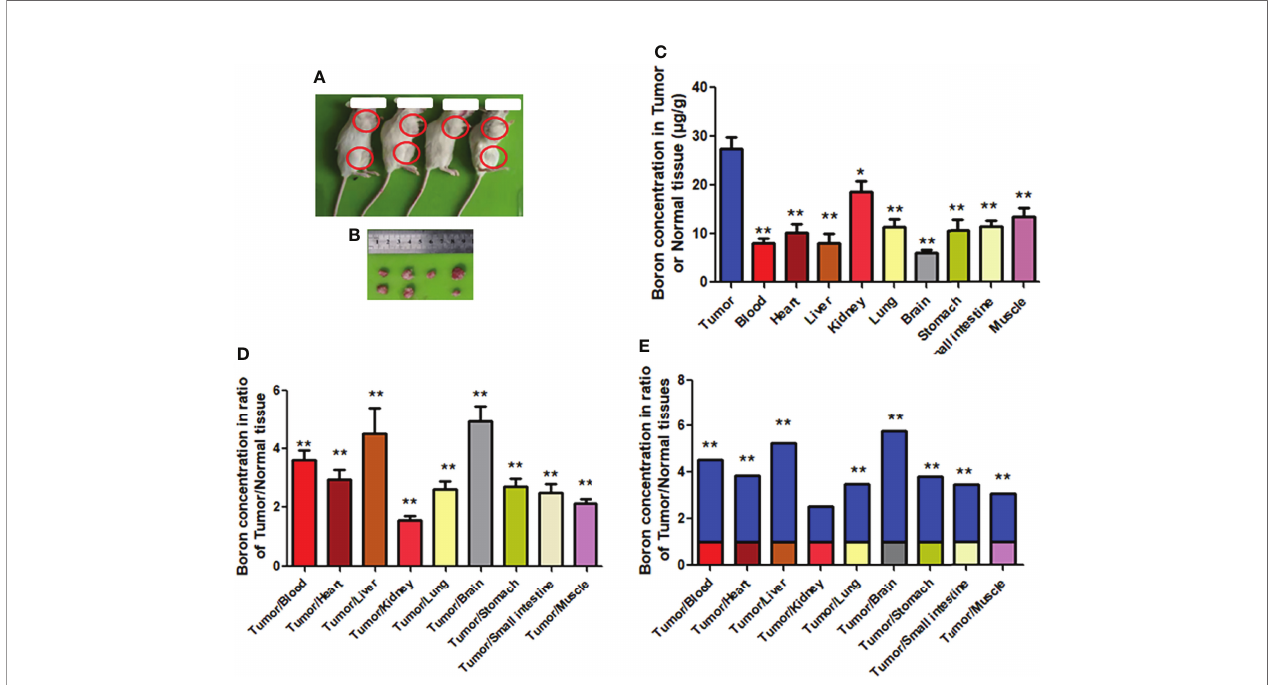
FIGURE 7 | Boron concentration in gastric tumor or tissue of PDX mice. (A , B) Mice bearing tumor. (C) The boron concentration in tumor, blood, and tissues of heart, liver, kidney, lung, brain, stomach, small intestine, and muscle. (D , E) Boron concentration ratios in tumor/blood or tumor/tissue. Data were expressed as the means ± SD. N = 6. The dose of BPA was 250 mg/kg body weight. The age of female mice was 12 weeks. Blood and tissues were collected at 1 h after BPA injection for boron measurement. * p < 0.05, ** p < 0.01 compared with tumor or